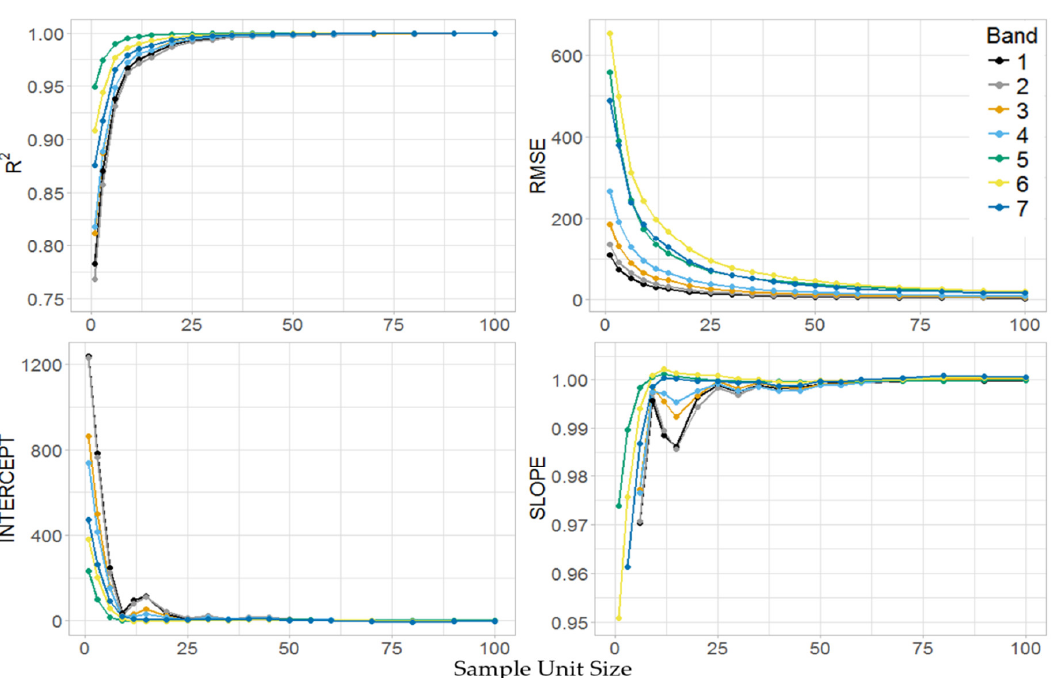
Figure A1. Stage I Landsat image regression statistics for varying bands and sample unit size lengths given an average image registration error of 1.6 cells and an average GPS navigational unit error of 0.23 cells.